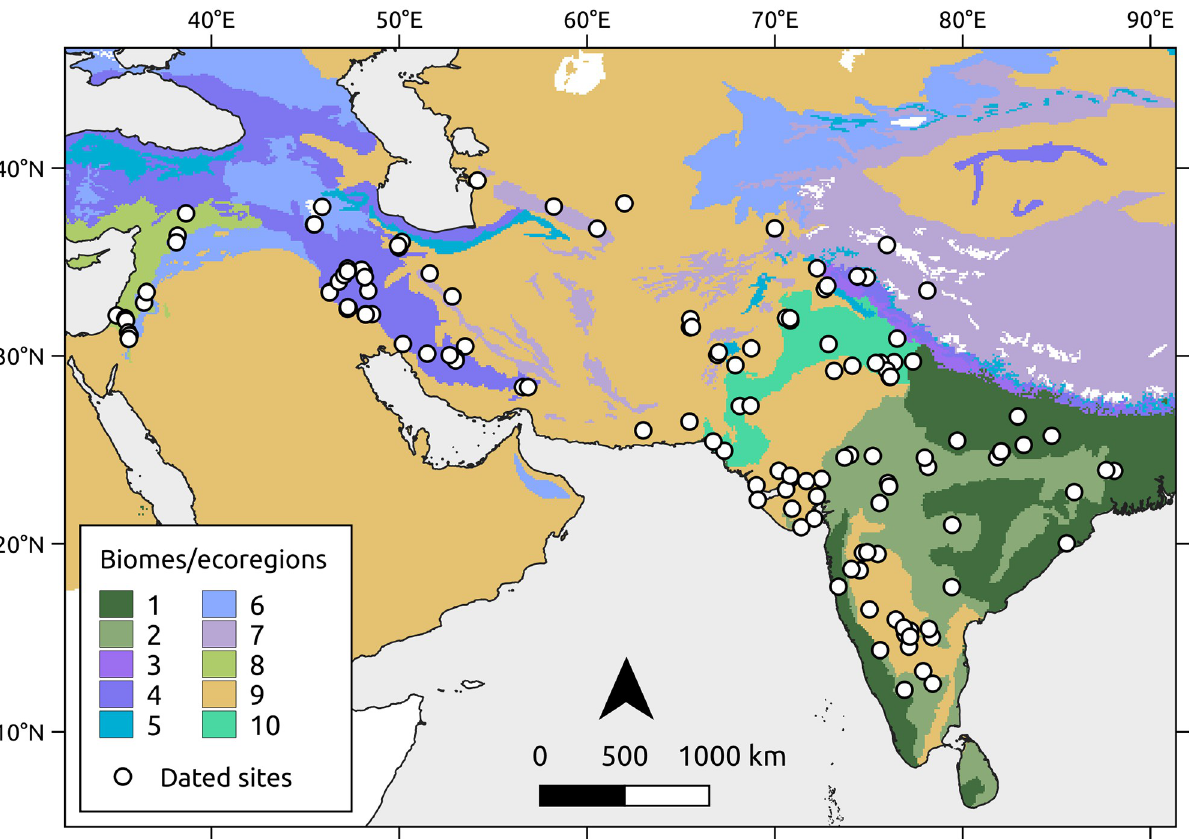
Fig 2. Biome classification [45] and distribution of dated sites. 1 = Tropical and subtropical moist broadleaf forests; 2 = Tropical and subtropical dry broadleaf forests; 3 = Tropical and subtropical coniferous forests; 4 = Temperate broadleaf and mixed forests; 5 = Temperate conifer forests; 6 = Temperate grasslands, savannas and shrublands; 7 = Montane grasslands and shrublands; 8 = Mediterranean forests, woodlands, and scrubs; 9 = Deserts and xeric shrublands; 10 = Indus Valley.